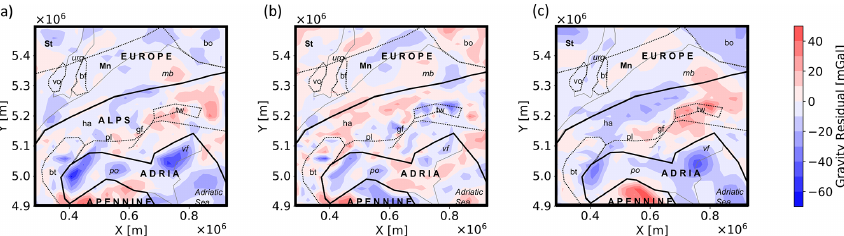
Figure 17. Gravity residual of (a) the General-Focus model, (b) the Crustal-Focus model, and (c) the difference between the General-Focus model and Crustal-Focus model. Acronyms are as follows: St stands for Saxothuringian Zone, Mn stands for Moldanubian Zone, Ha stands for Helvetic Alps, bo stands for Bohemian Massif, vo stands for Vosges Massif, bf stands for Black Forest Massif, tw stands for Tauern Window, bt stands for Briançonnais Terrane, pl stands for Periadriatic Lineament, gf stands for Guidicarie Fault, urg stands for Upper Rhine Graben, mb stands for Molasse Basin, po stands for Po Basin, and vf stands for Veneto–Friuli